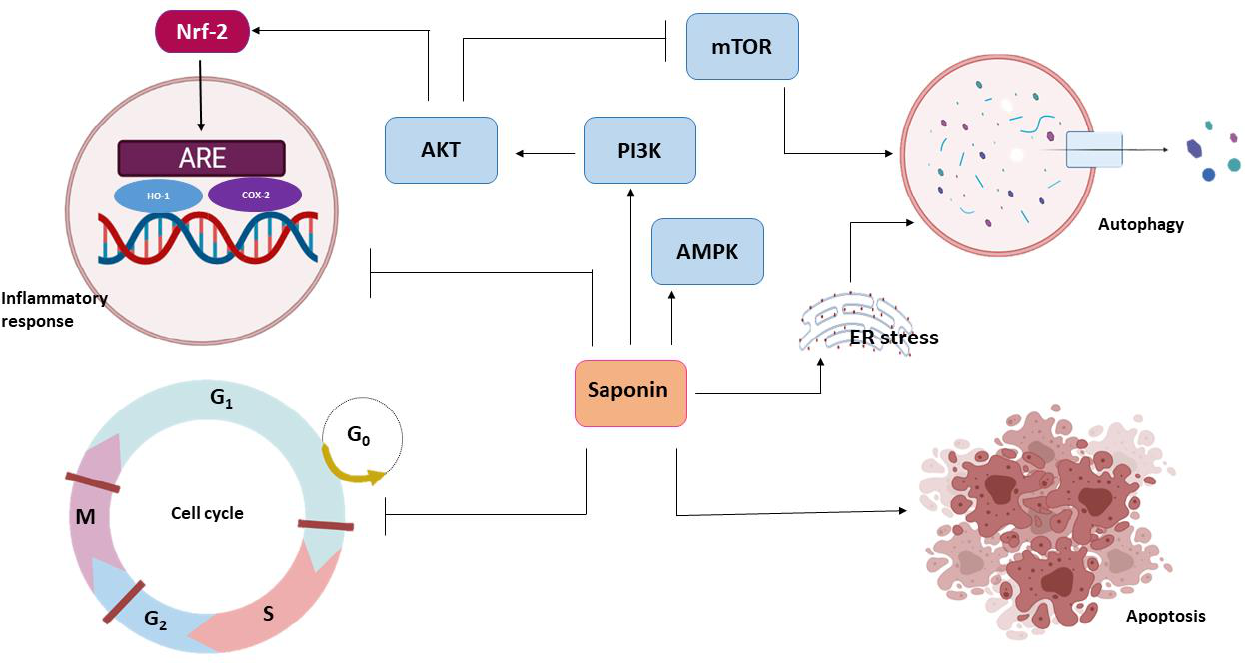
Figure 3. Anticancer effects of saponins.